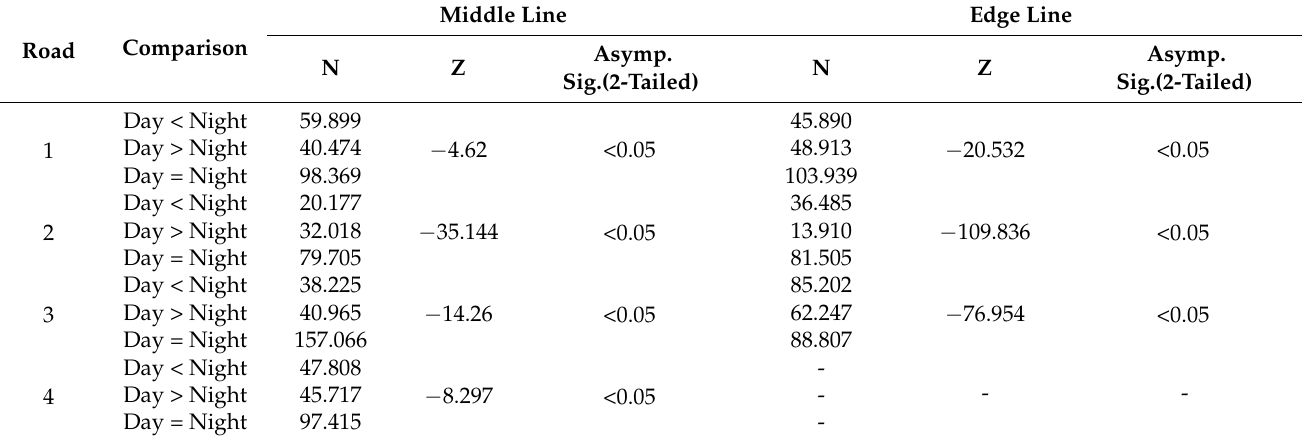
Table 4. Results of Wilcoxon signed-rank test for middle and edge lines on analysed roads.